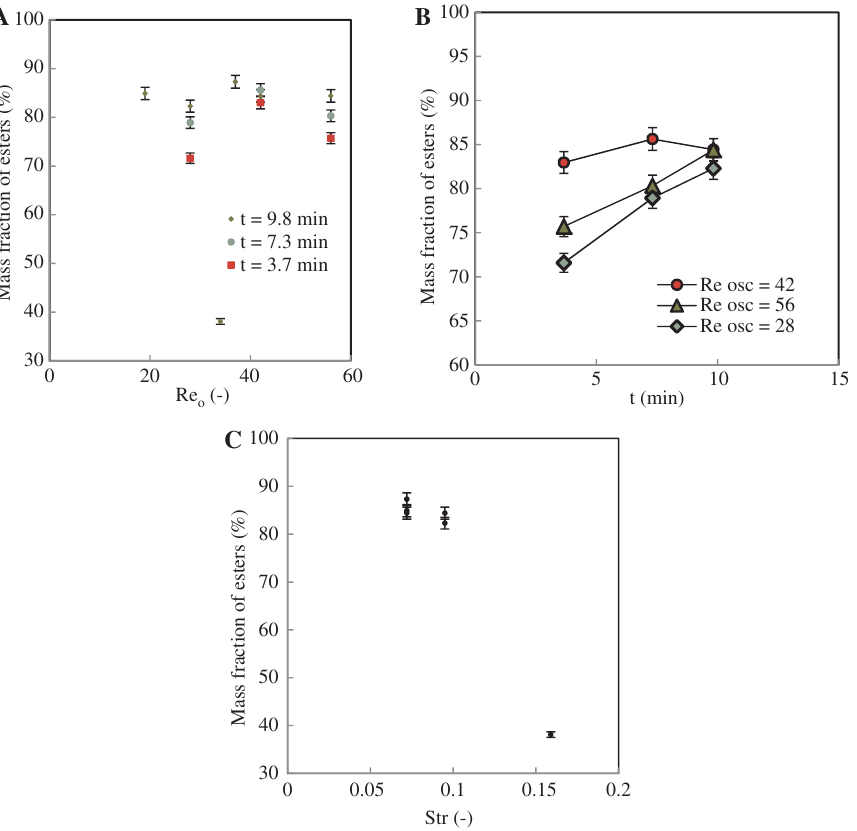
Figure 5 (A, B) Influence of the oscillatory Reynolds number and (C) Strouhal number on the mass fraction of esters at T = 27 ° C.